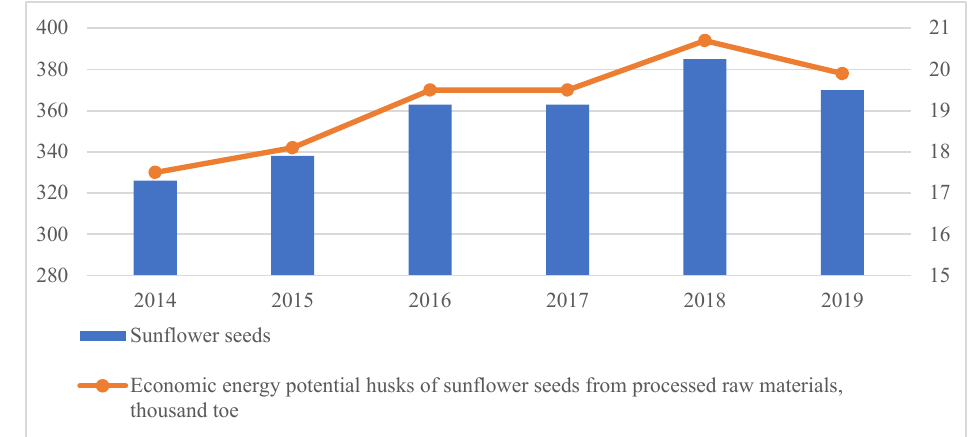
Figure 4. Volumes of processed raw materials, thousand tonnes. Source: author’s calculations are based on statistics from the State Statistics Service of Ukraine [23].